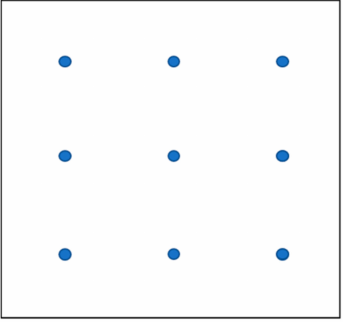
Figure 1. Application points selected for spray